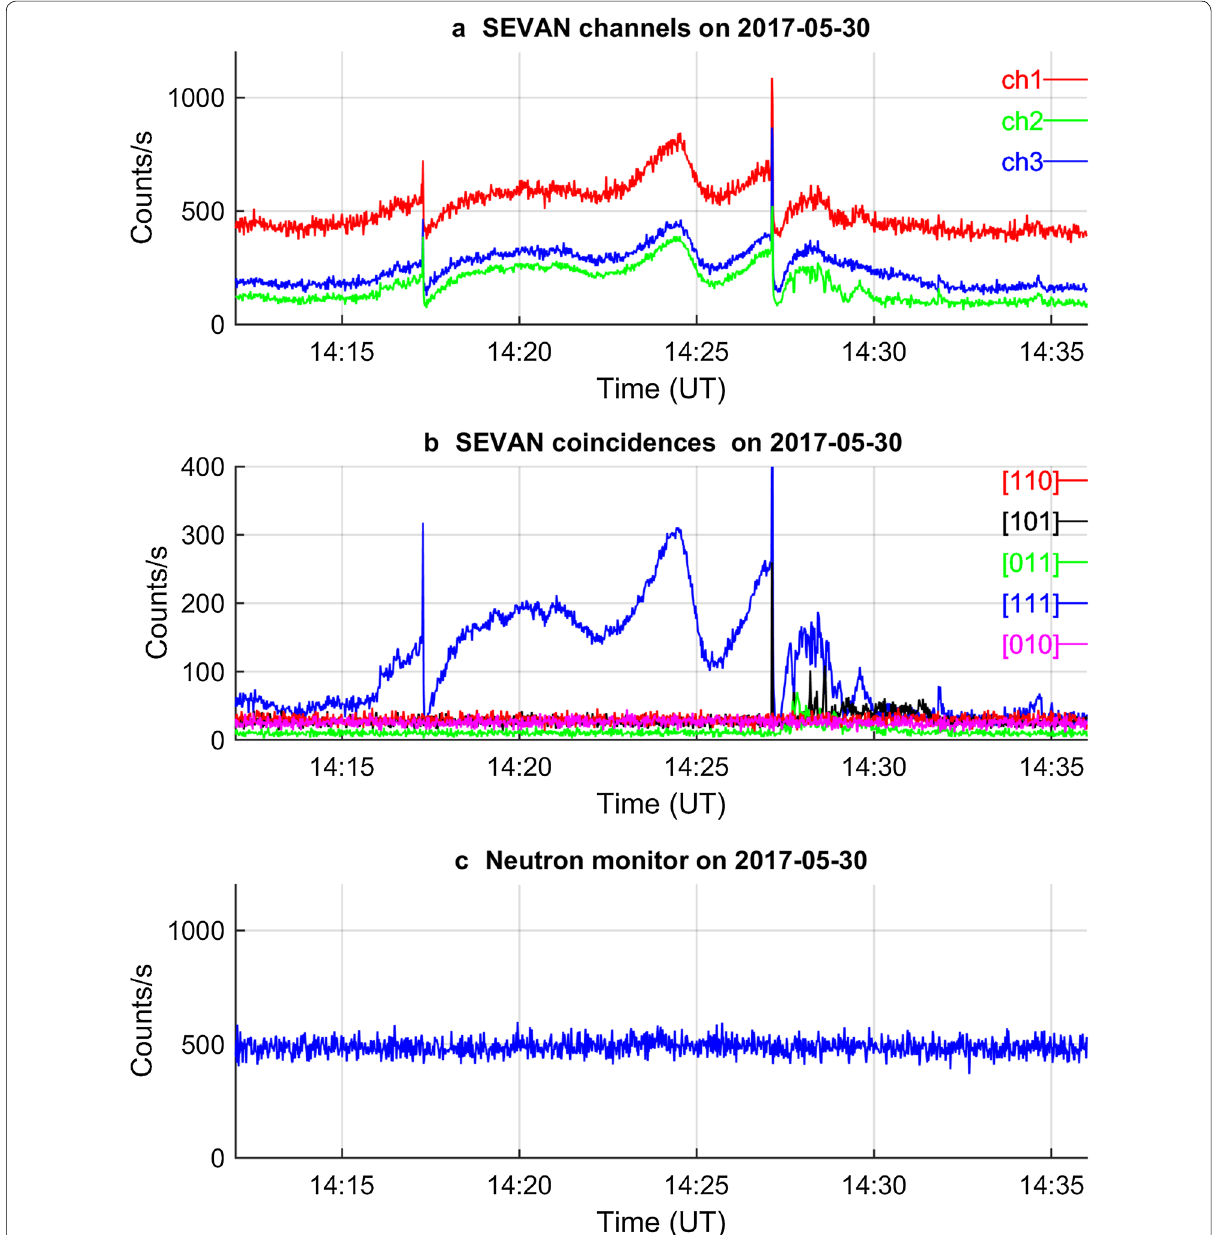
Fig. 9 Event recorded by SEVAN and neutron monitor on 30 May 2017 around 14:24 UT. a Raw counts recorded by individual SEVAN channels. b Coincidences recorded by different combinations of SEVAN channels. c Raw counts recorded by neutron